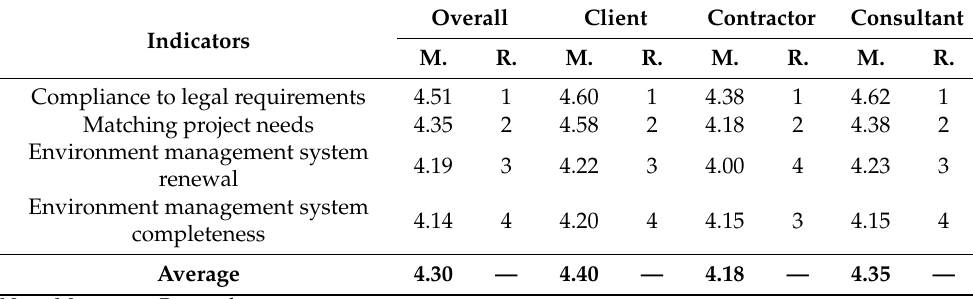
Table 1. Environment management system.